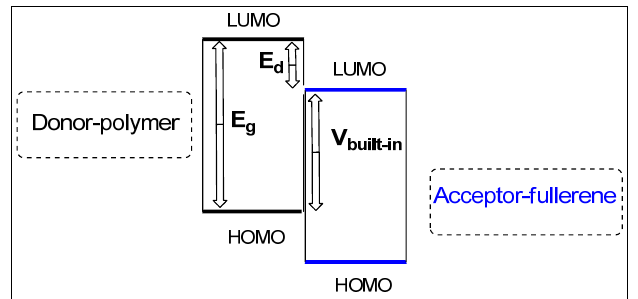
Figure 14. Schematic energy-band diagram of a simple BHJ solar cell consisting of polymer/fullerene derivatives.